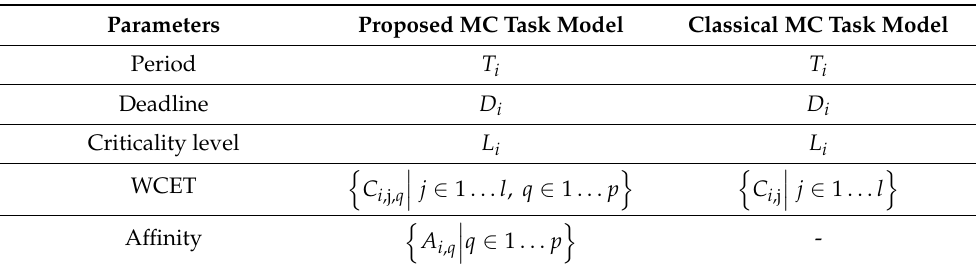
Table 1. Parameter Comparison Between the Proposed MC Task Model and the Classical MC Task Model.